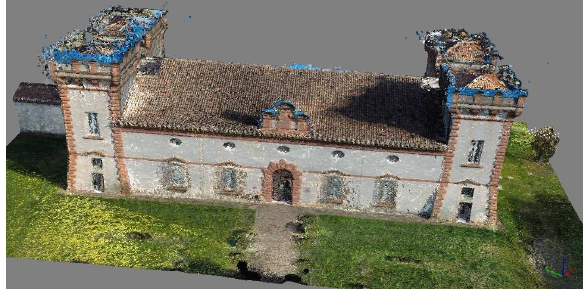
Figure 24: Point clouds obtained using fisheye release (project made using all dataset simultaneously) Figures 25 and 26 show the deviations and their distribution, between global model obtained and the reference model. As can be seen, the results are absolutely acceptable.